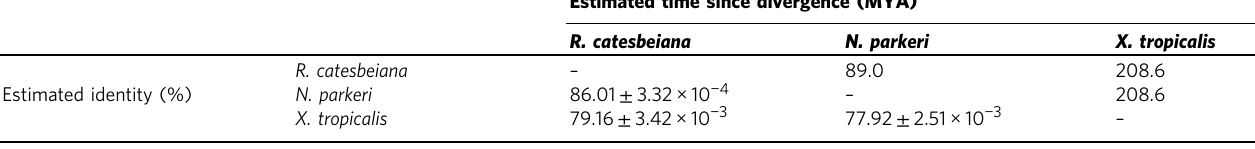
Table 2 ABySS-Bloom sequence identity calculations between amphibian genome assemblies Estimated time since divergence